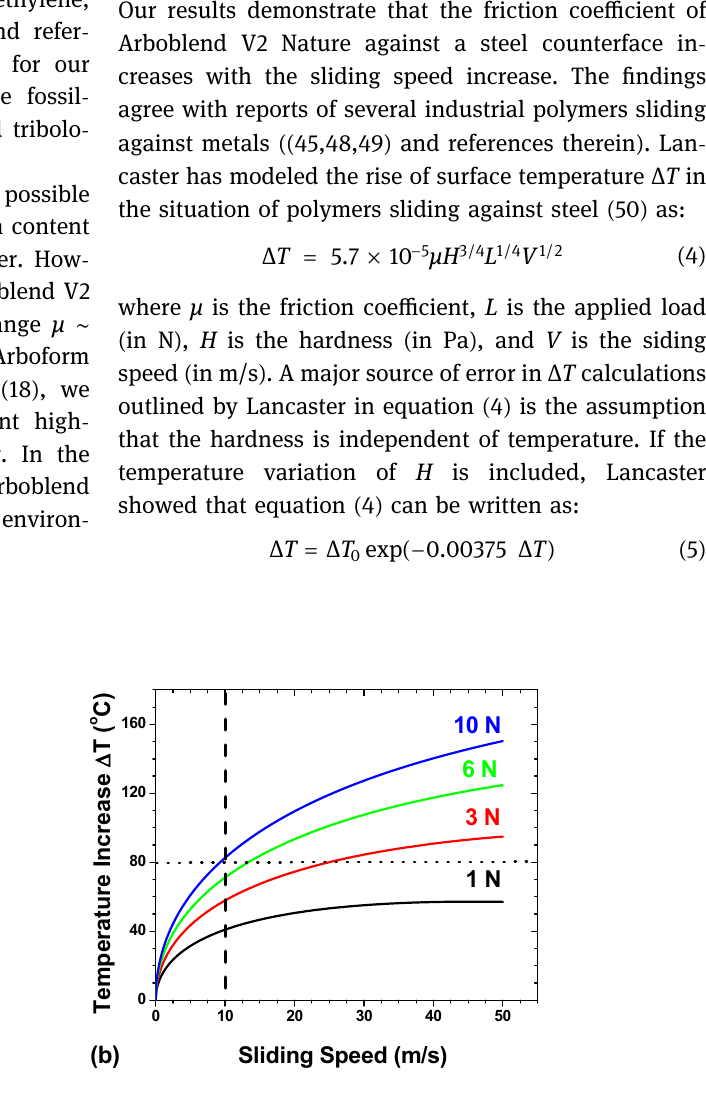
Figure 9: ( a ) Friction coe ffi cient versus the number of cycles at L = 3 N measured at di ff erent sliding speeds; ( b ) increase of temperature at the contact area polymer/steel as a function of sliding speed for di ff erent applied